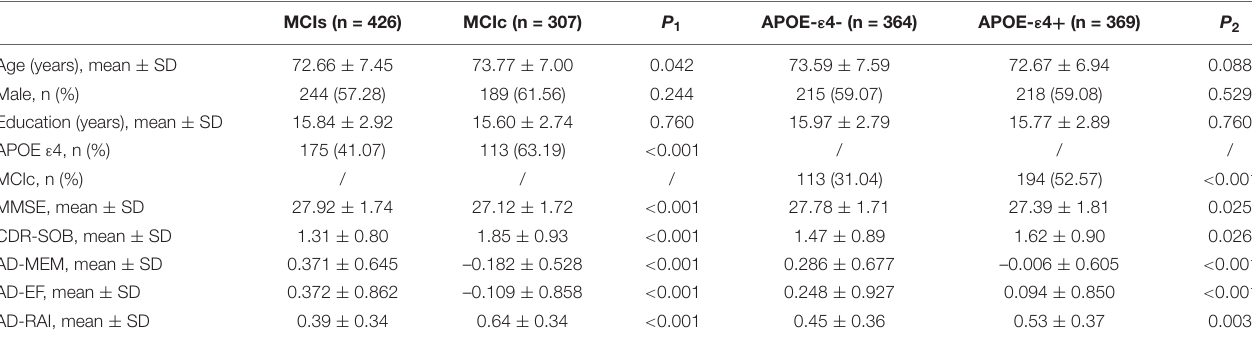
TABLE 1 | Demographic and general clinical characteristics by MCI, APOE